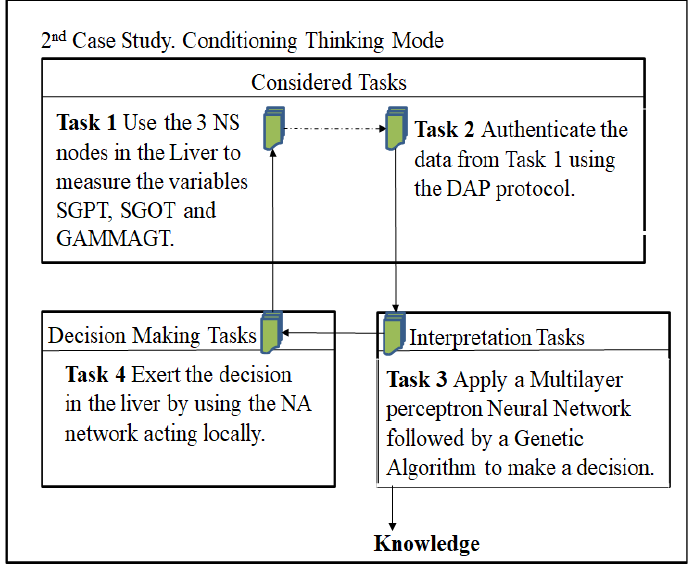
Figure 4. Instantiation of the CTM AC for the 2nd Case Study.